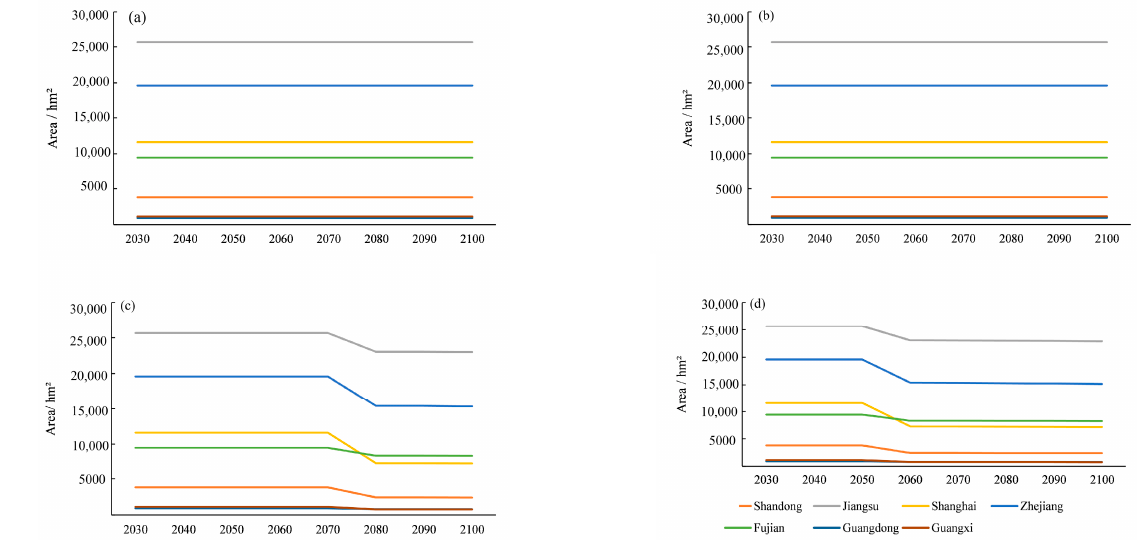
Figure 4. S. alterniflora changes by regions. The color of the line indicates different regions (Shandong, Jiangsu, Shanghai, Zhejiang, Fujian, Guangdong, Guangxi), ( a ) SSP1-2.6, ( b ) SSP2-4.5, ( c ) SSP3-7.0, ( d ) SSP4-8.5. Table 4. S. alterniflora changes by regions compared with the year 2015. (a) S. alterniflora changes by regions compared with the year 2015 under SSP3-7.0.